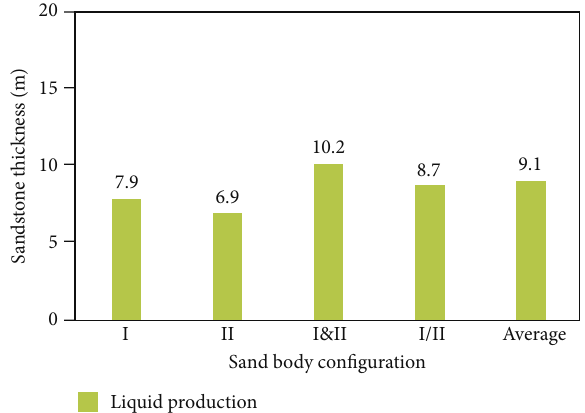
Figure 16: Comparison of sand thickness of di ff erent sand body con fi